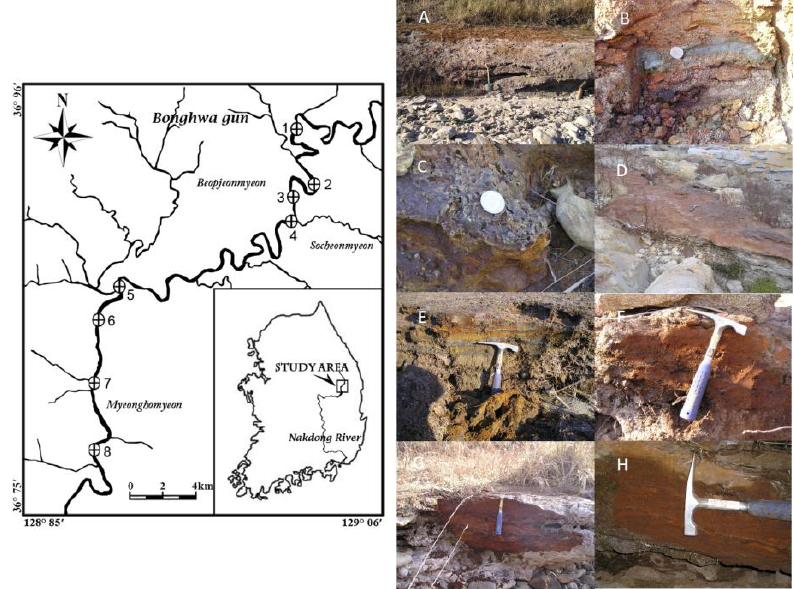
Figure 1. Sampling points (left) and weathered tailings layers (right) observed on the riverbank of the Nakdong River: ( A , B ) Point 1, ( C ) Point 2, ( D ) Point 3, ( E ) Point 4, ( F ) Point 5, ( G ) Point 6, and ( H ) Point 7.